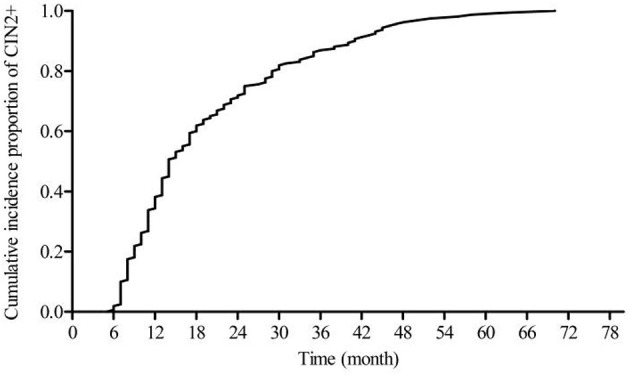
Cumulative proportion of CIN2+.